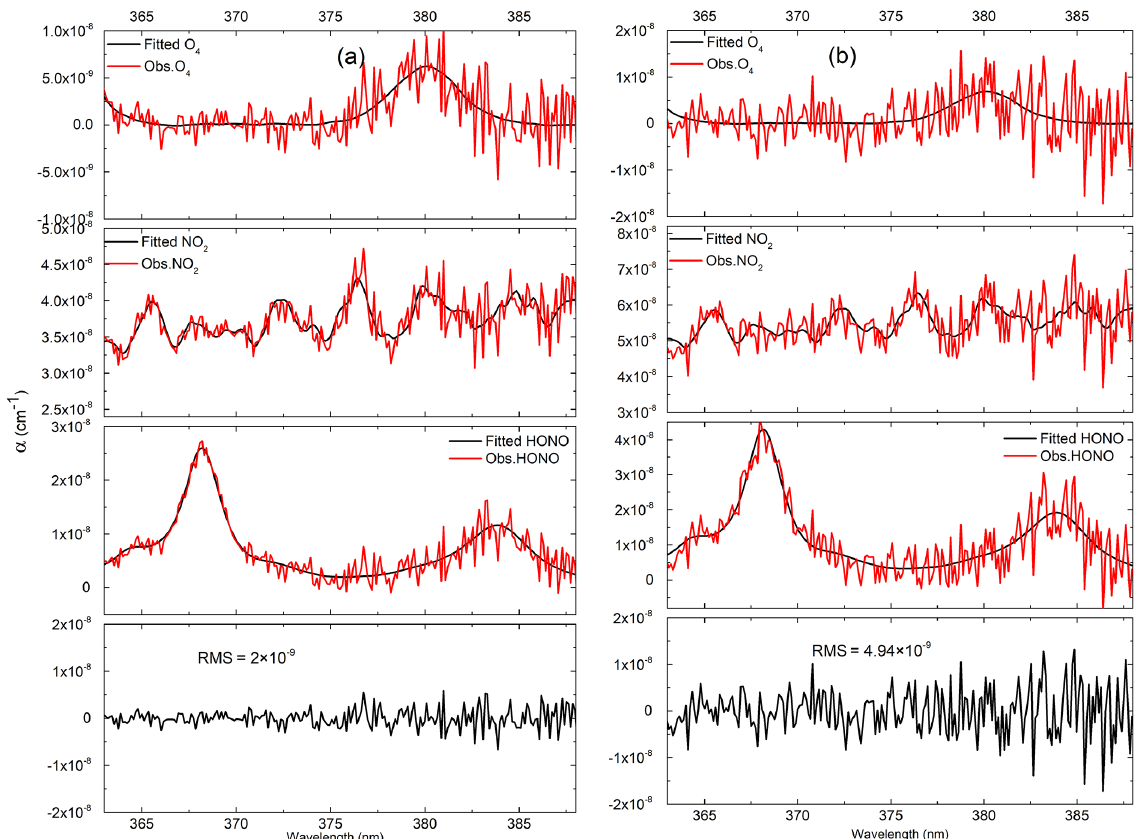
Figure 9. Spectral fitting results of (a) method 3 and (b) method 2 after light intensity change. The RMS of fit residuals in method 2 is 4 . 94 × 10 − 9 ; the RMS of fit residuals in method 3 is 2 × 10 − 9 .